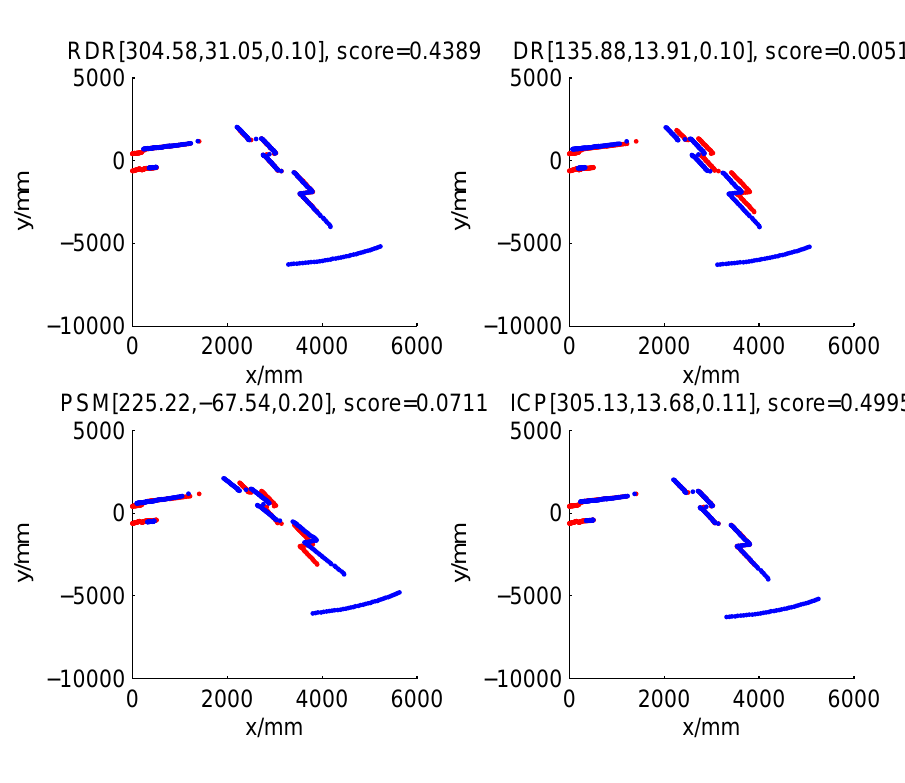
Figure 19. Robust dead reckoning result for Case 3a (time Step